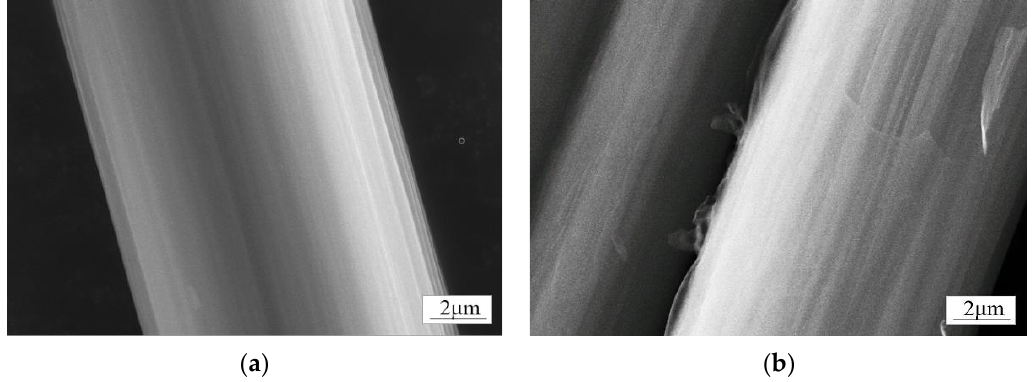
Figure 7. SEM images of the surface morphology of CF and GO-CF hybrid fibers. ( a ) desized CF, ( b ) GO-CF.